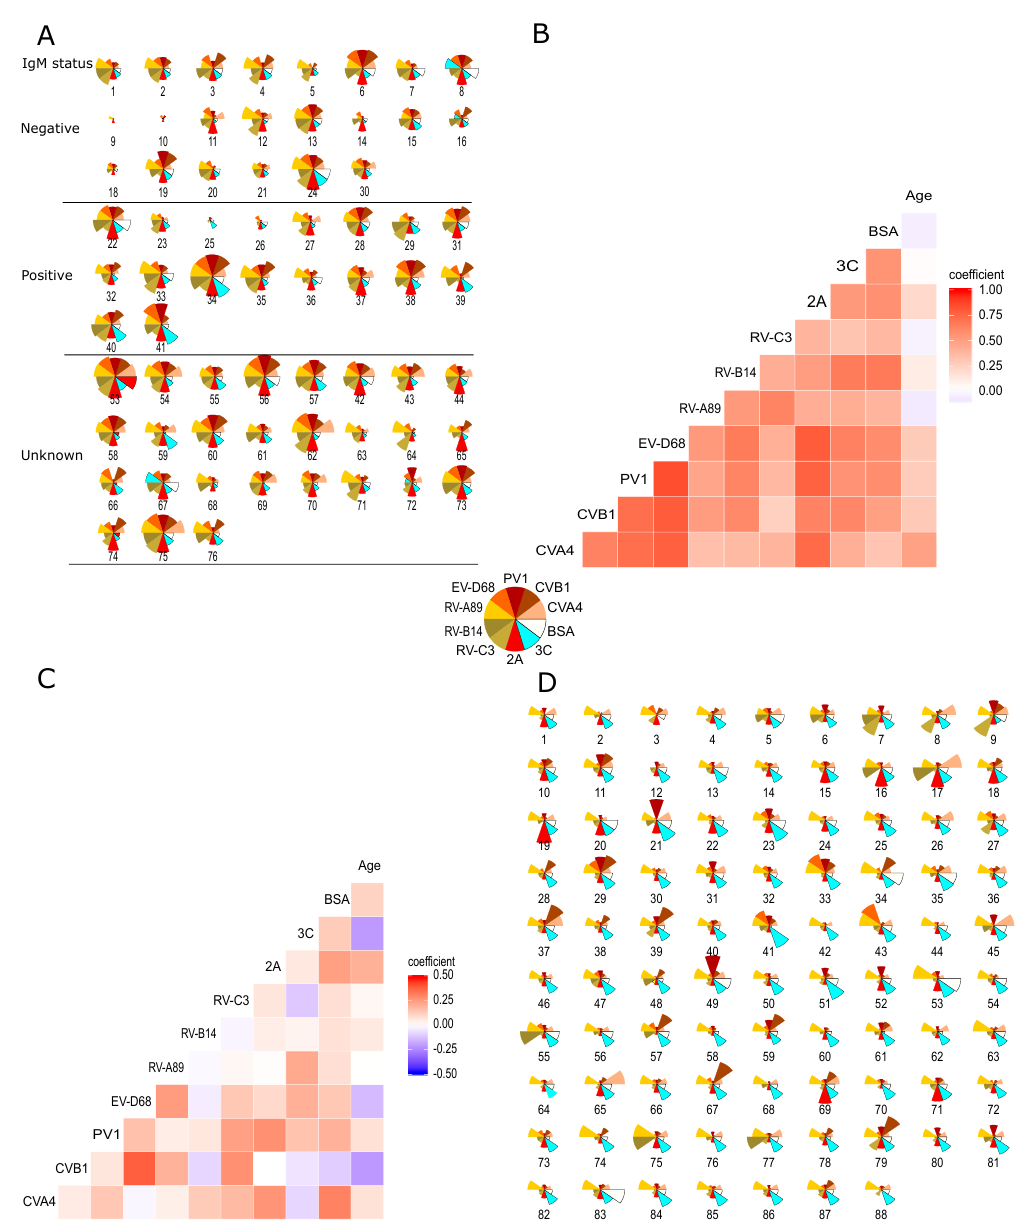
Figure 5. Antigen specific min-max normalized antibody responses and correlations of antibody responses between di ff erent enterovirus antigens. Antigen specific min-max normalized antibody responses (see Equation (2)) in the multiplex assay illustrated as radar plots for individual ( A ) adults and ( D ) children. Radii of the sectors represent normalized signal intensities. Age grouped Spearman correlations for antibody responses are illustrated as matrices for adults ( B ) and children ( D ). Min-max normalization was performed separately for adults and children, due to di ff erences in signal levels in the two groups. Comparing ( A ) to ( D ) and ( B ) to ( C ), the di ff erences between antibody responses in adults and children become